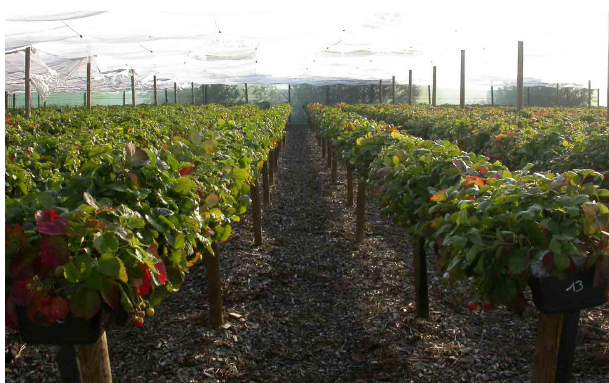
Figure 5. Gally farms, near the Castle of Versailles. Straw- berry crops under